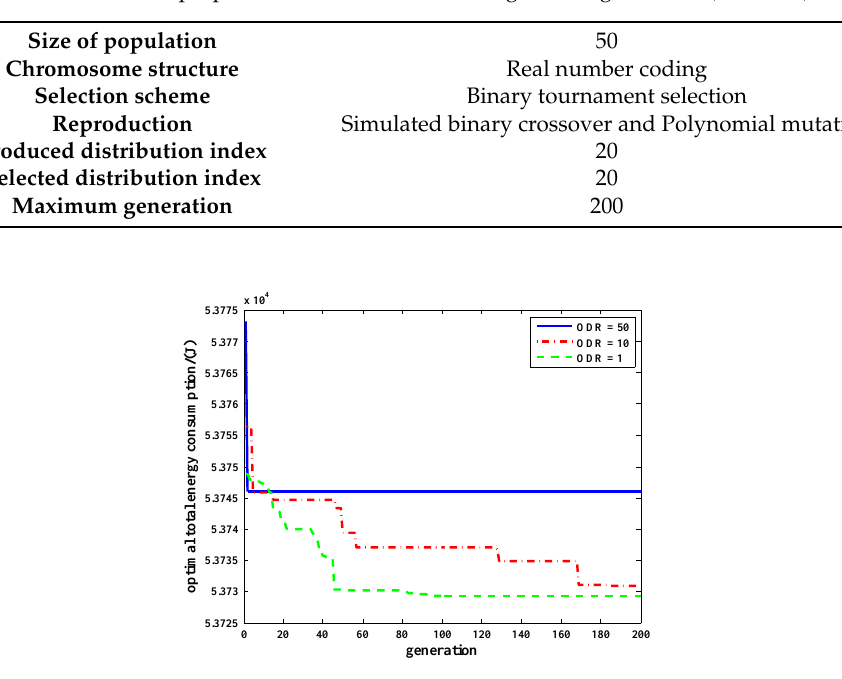
Figure 17. The optimal result of NSGA-II method with different